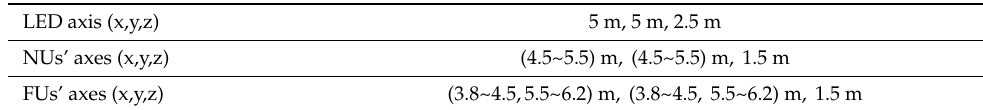
Figure 8. Loss for learning. Table 4. Users’